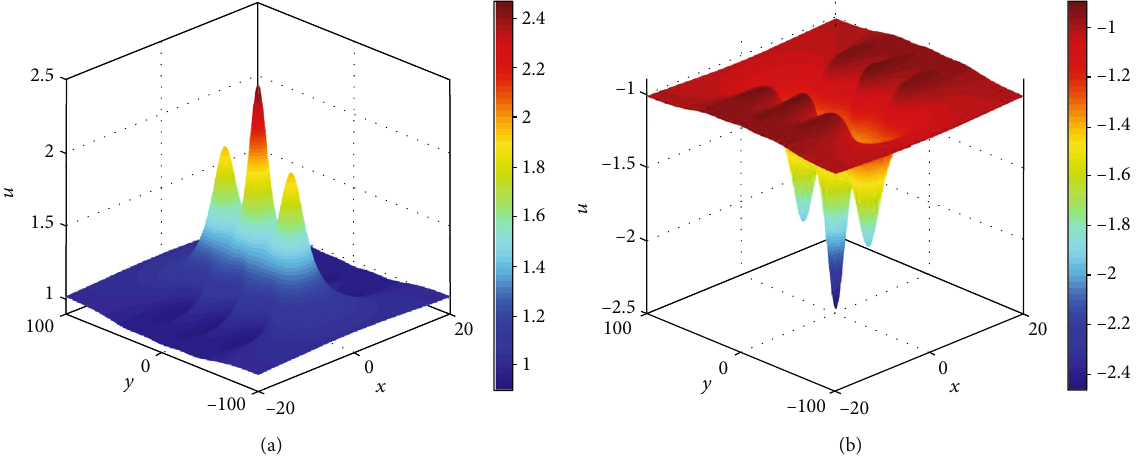
= 1 and c = − 1 . (b) Dark-type lump with 0